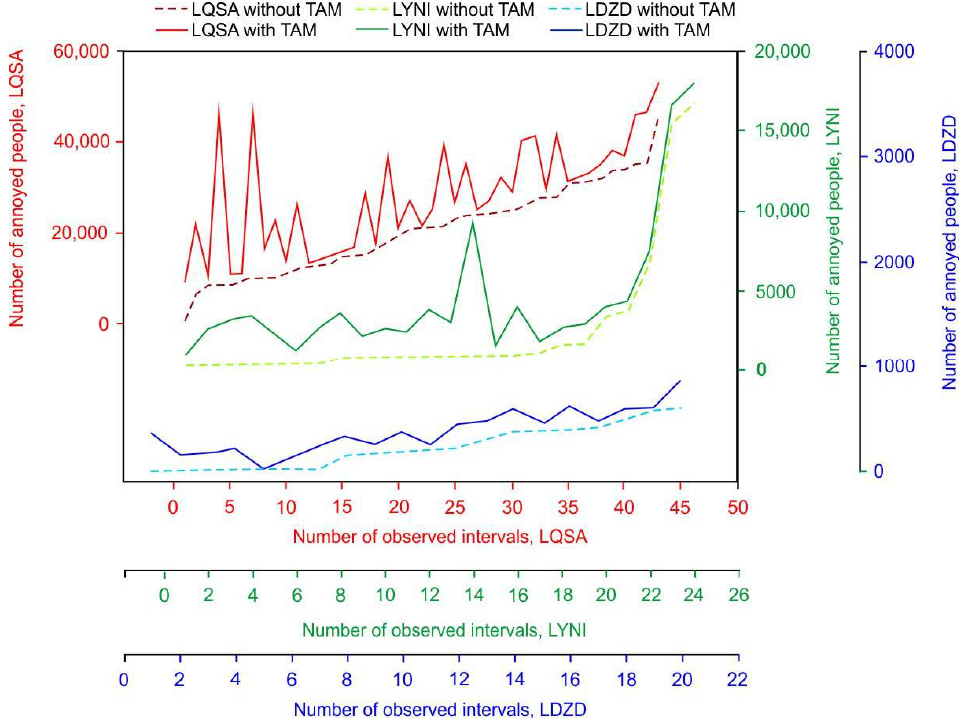
Figure 2. Comparative analysis of annoyed people around airports of Sarajevo, Zadar and Niš.